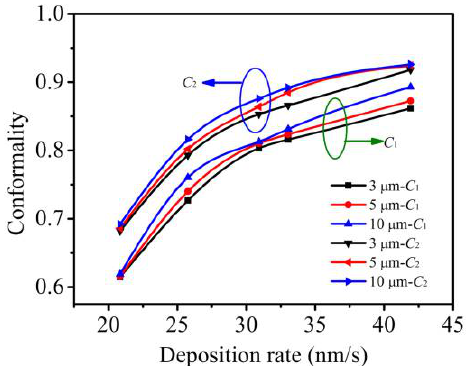
Figure 6. Conformality as functions of the deposition rate.